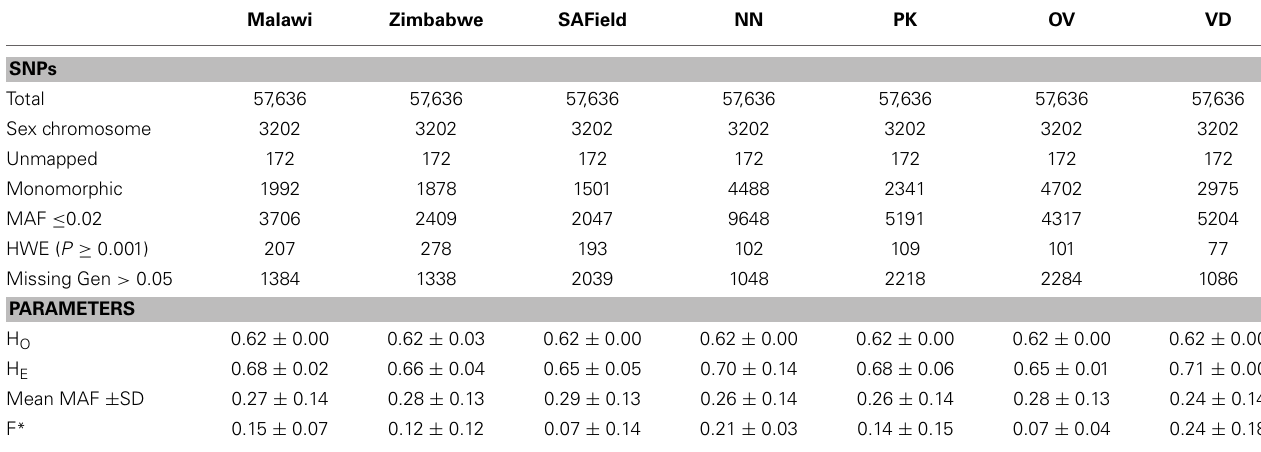
Table 1 | SNP distribution after quality control and the minor allele frequency (MAF), observed (H O ), expected (H E ) heterozygosities and inbreeding coefficient (F) of Malawi, South African field (SAField), Zimbabwean chicken populations as well as the Naked Neck (NN), Potchefstroom Koekoek (PK), Ovambo (OV) and Venda (VD) conservation flocks from South Africa.